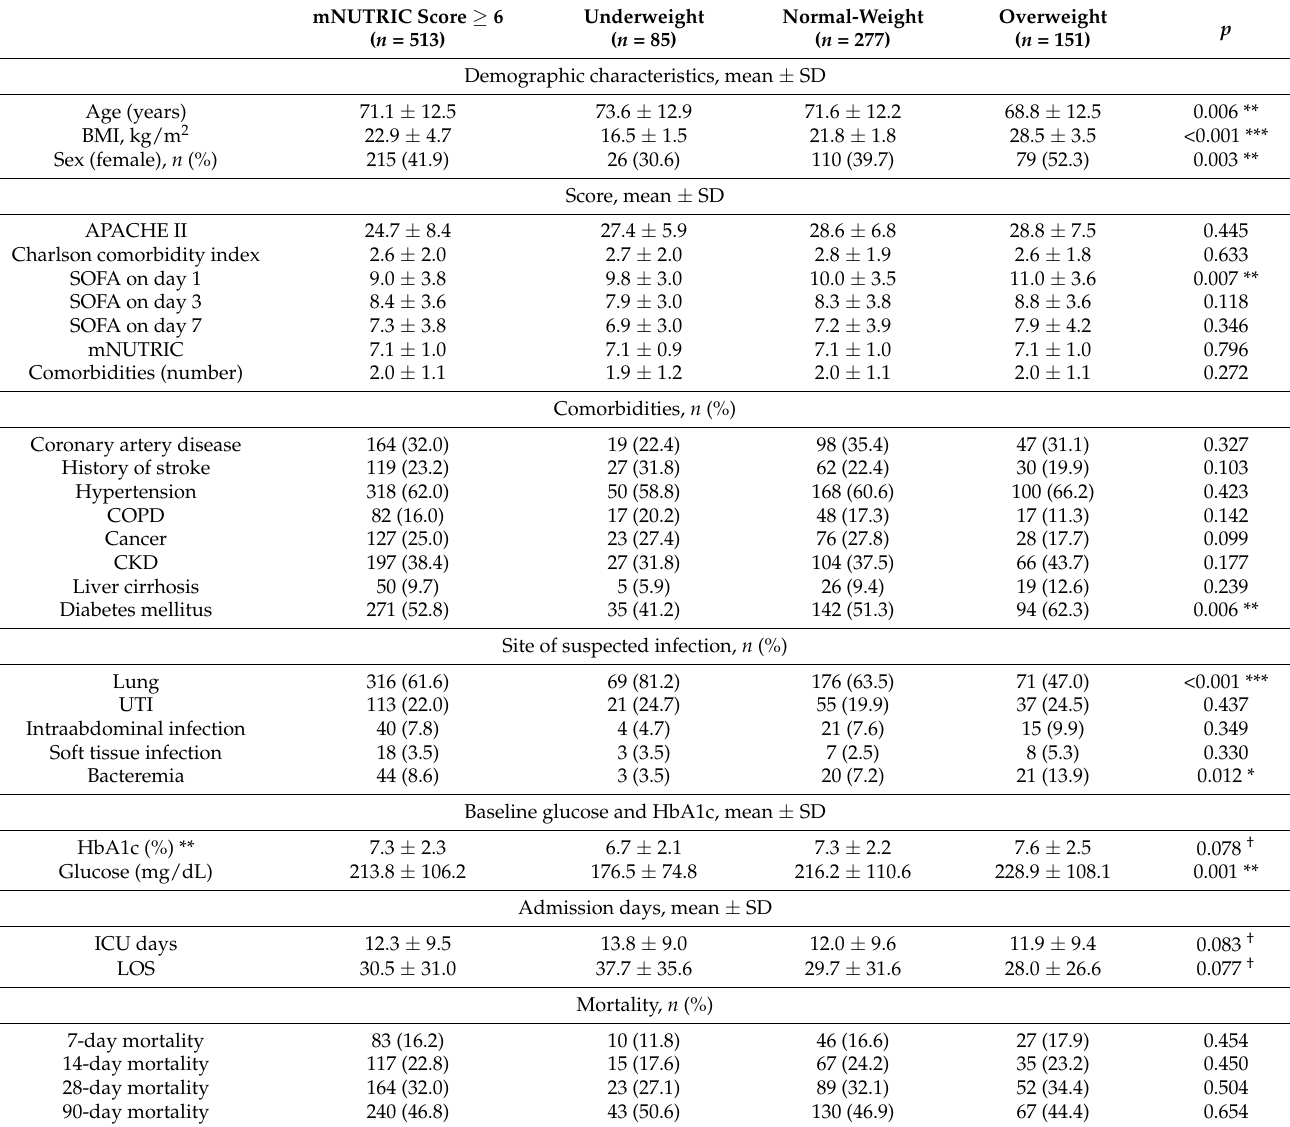
Table 5. Baseline characteristics and outcomes of patients with sepsis who had high modified NUTRIC